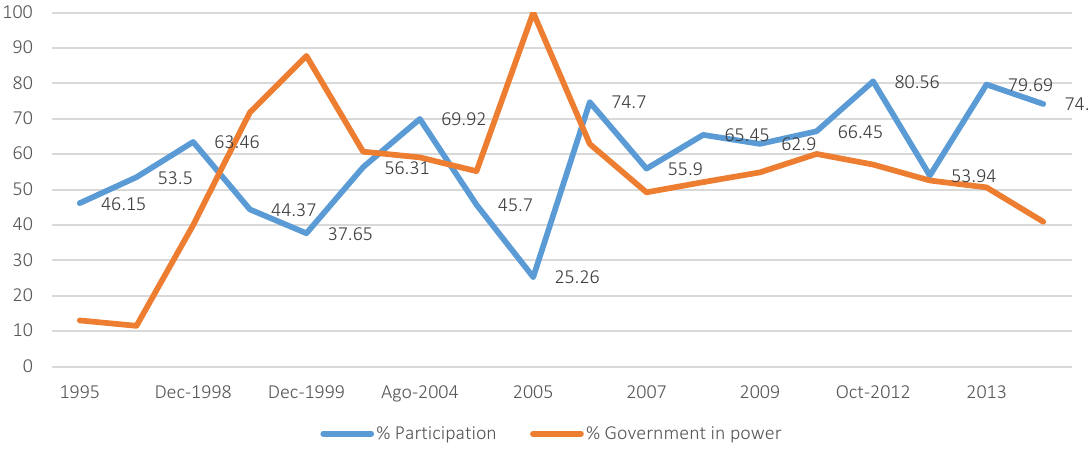
Figure 2. Participation of citizens in national elections in Venezuela